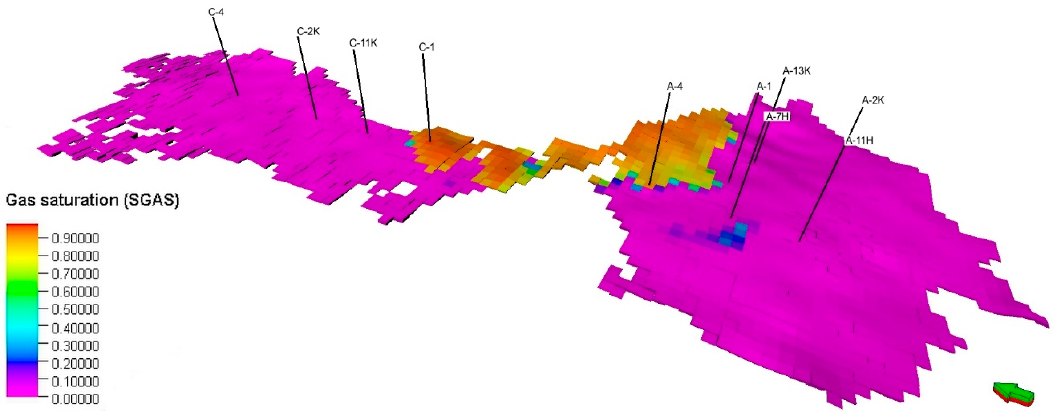
Figure 8. 3D view of the model top layer of the original gas saturation.